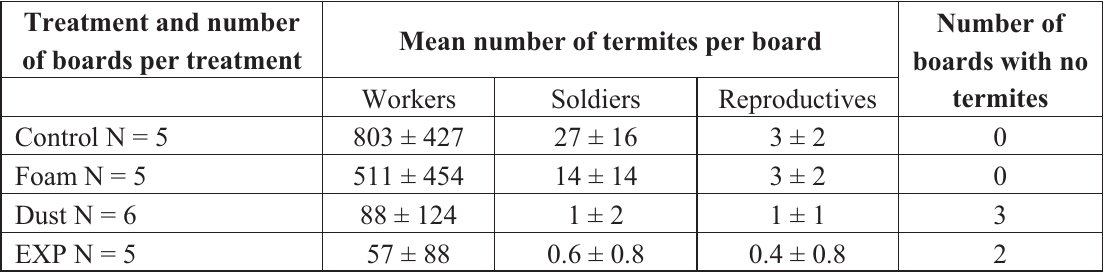
Table 4. Mean number of termites per board by treatment, caste, and the number of boards where no termites were found 65 days after treatment by destructive